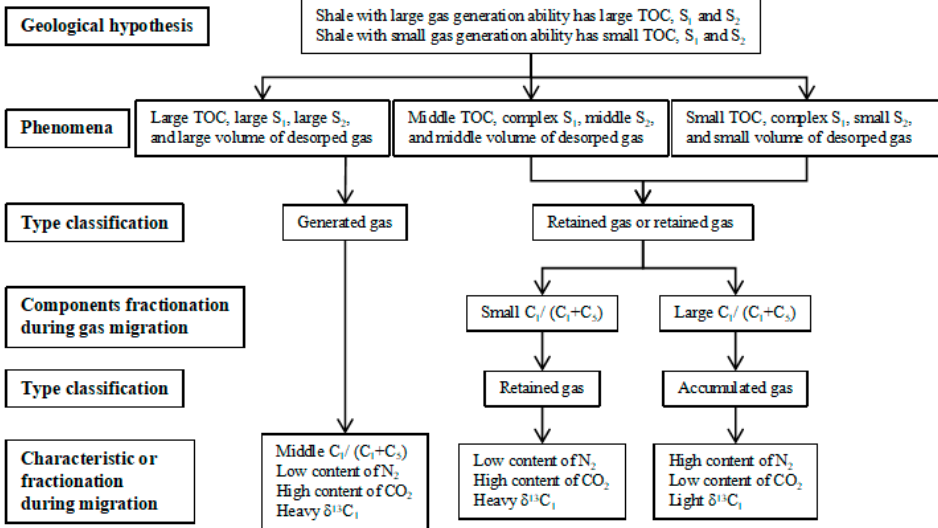
Figure 8. Chart showing classification of gas types.